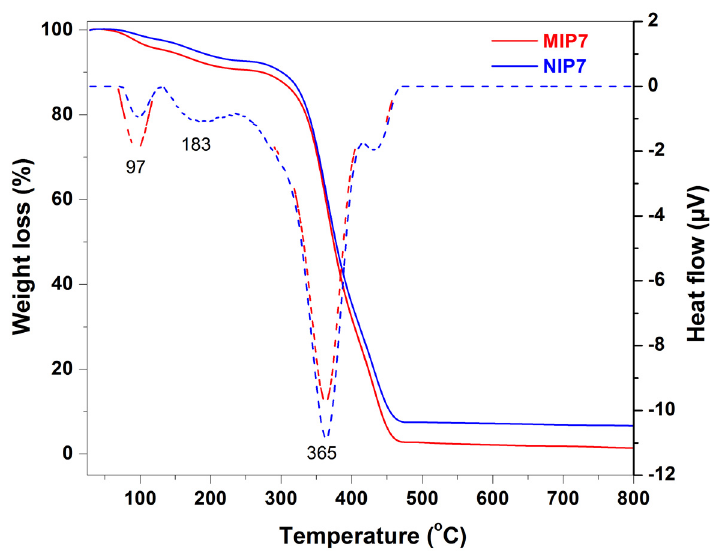
Figure 2. TGA analysis (solid curves) and DSC thermograms (dash curves) of MIP7 and NIP7.